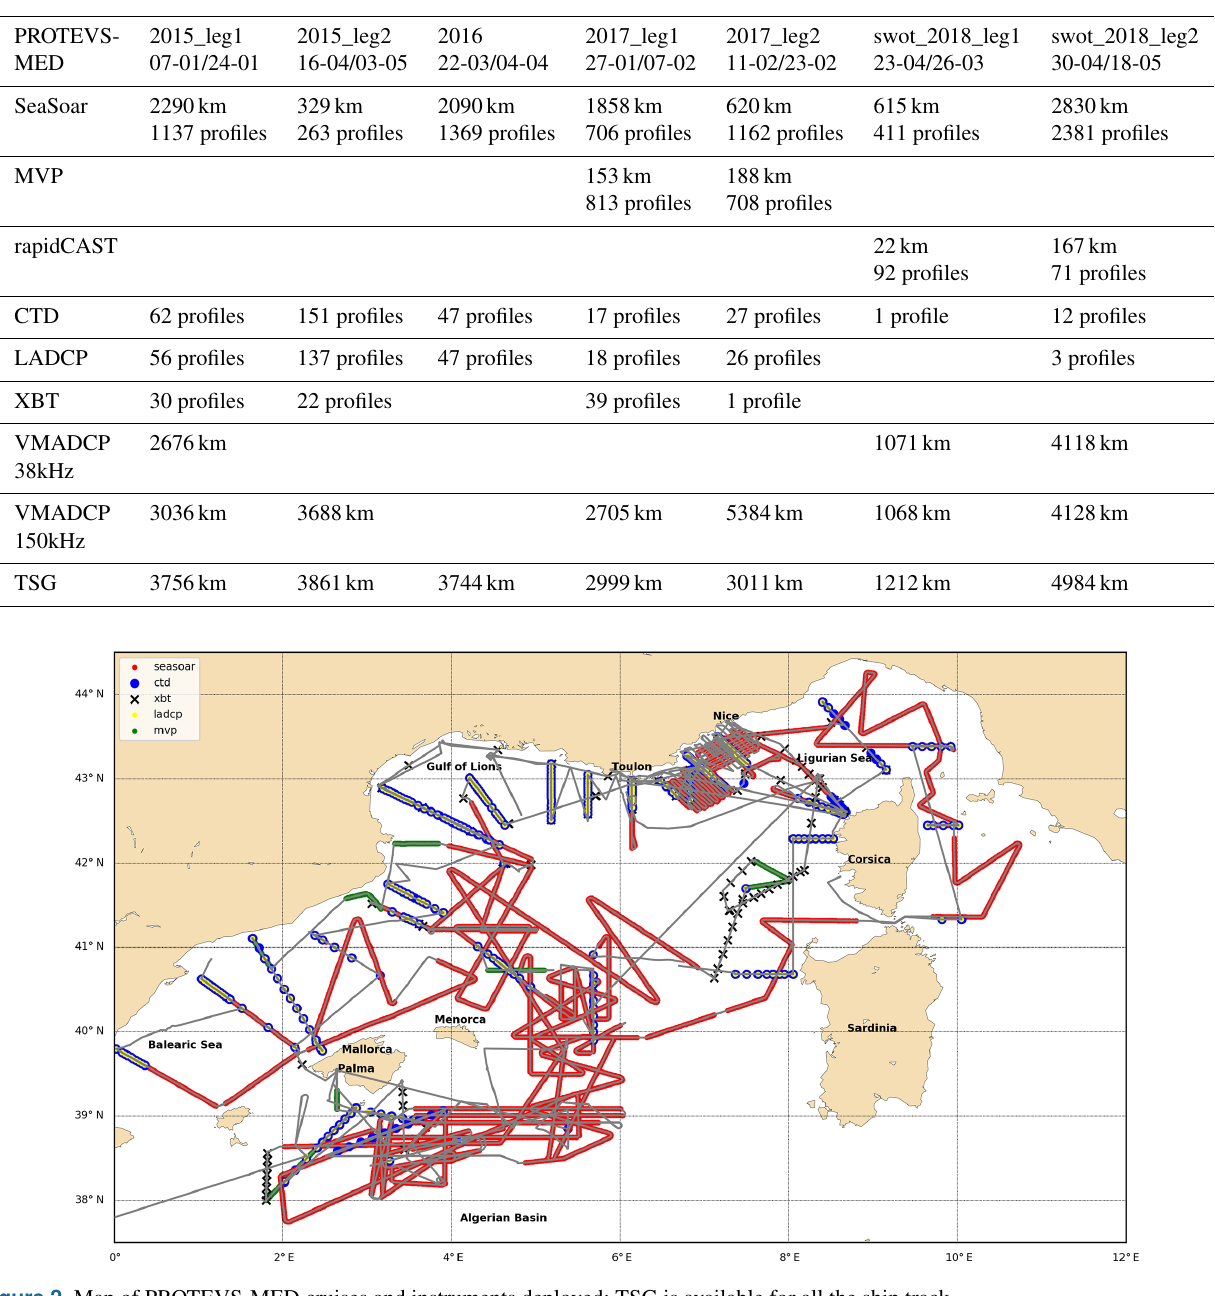
Table 1. Summary of measured transects, profiles and routinely acquired data. Cumulated length of transects and total numbers of vertical profiles are displayed.